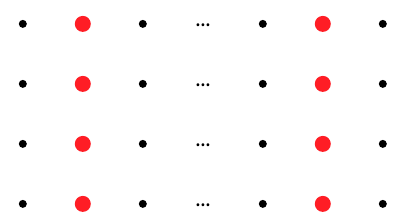
FIG. 24. Physical Hilbert space of the fermion-to-qubit map- ping with r = 1 + 1 / l . Each black site denotes one qubit, and each red site denotes two qubits. Columns of red vertices are separated by a distance l